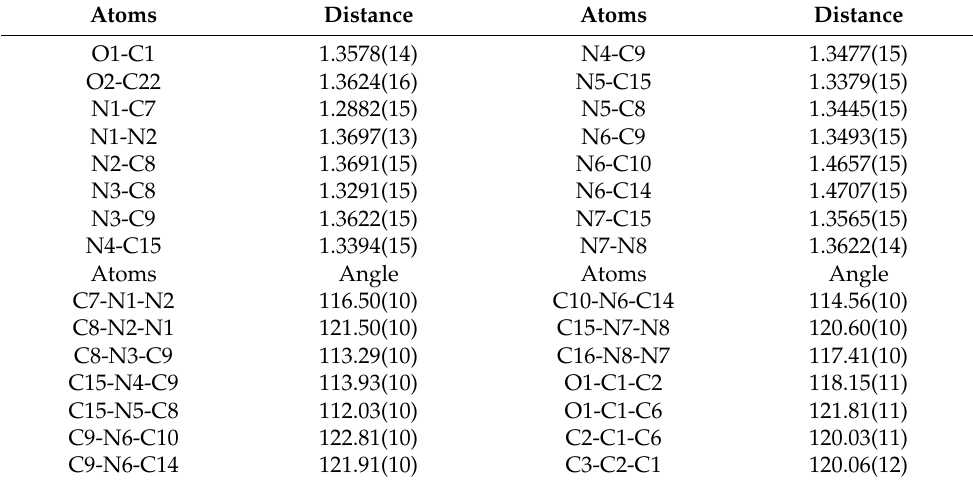
Table 2. Selected bond lengths [Å] and angles [°] for 4 .